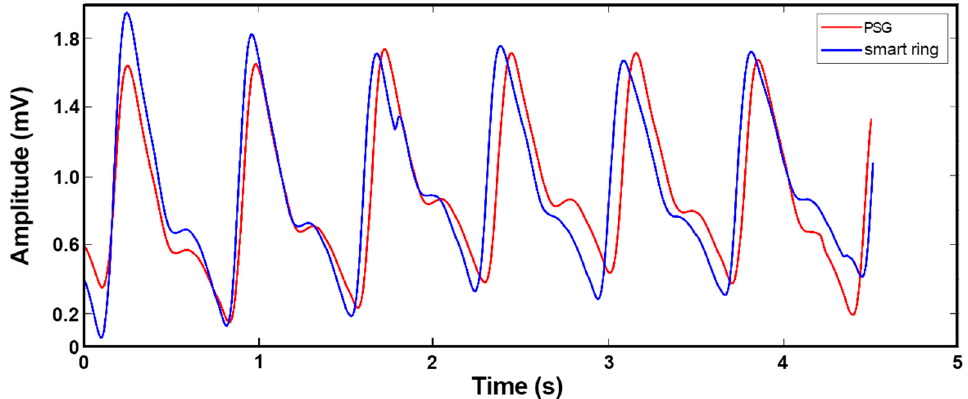
Figure 13. Pulse waves collected by the smart ring (blue) and a professional polysomnograph instrument (red),